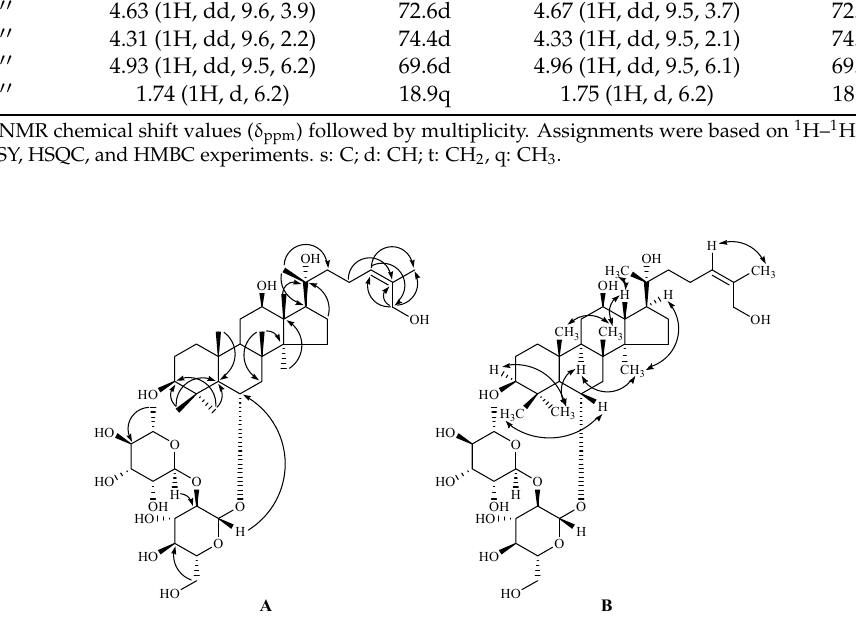
Figure 2. Key HMBC (from H to C, A ) and NOESY ( B ) correlations of M1 . Figure 3. Key HMBC (from H to C, A ) and NOESY ( B ) correlations of M1